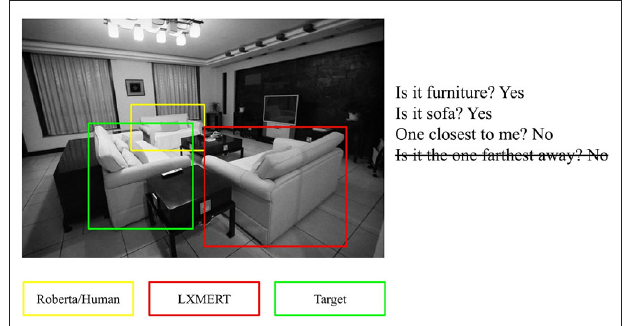
FIGURE 5 | Errors made by humans and computational models when receiving dialogues without the last turn.